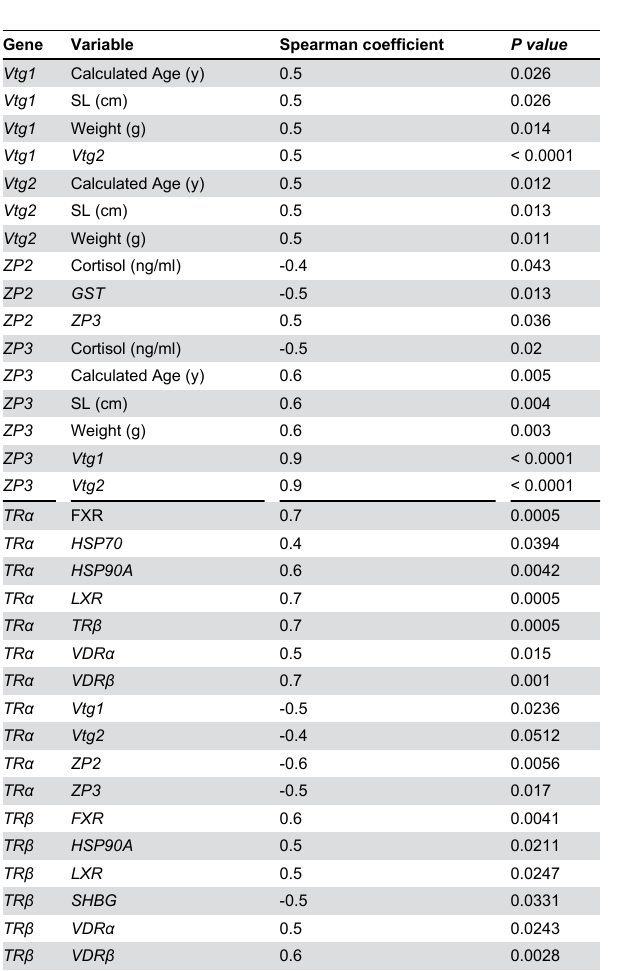
Table 3. Significant Spearman correlation analysis between gene expression data for Vtg1, Vtg2, ZP3, TRα , TRβ and defined phenotypic endpoints or other differentially regulated transcripts.